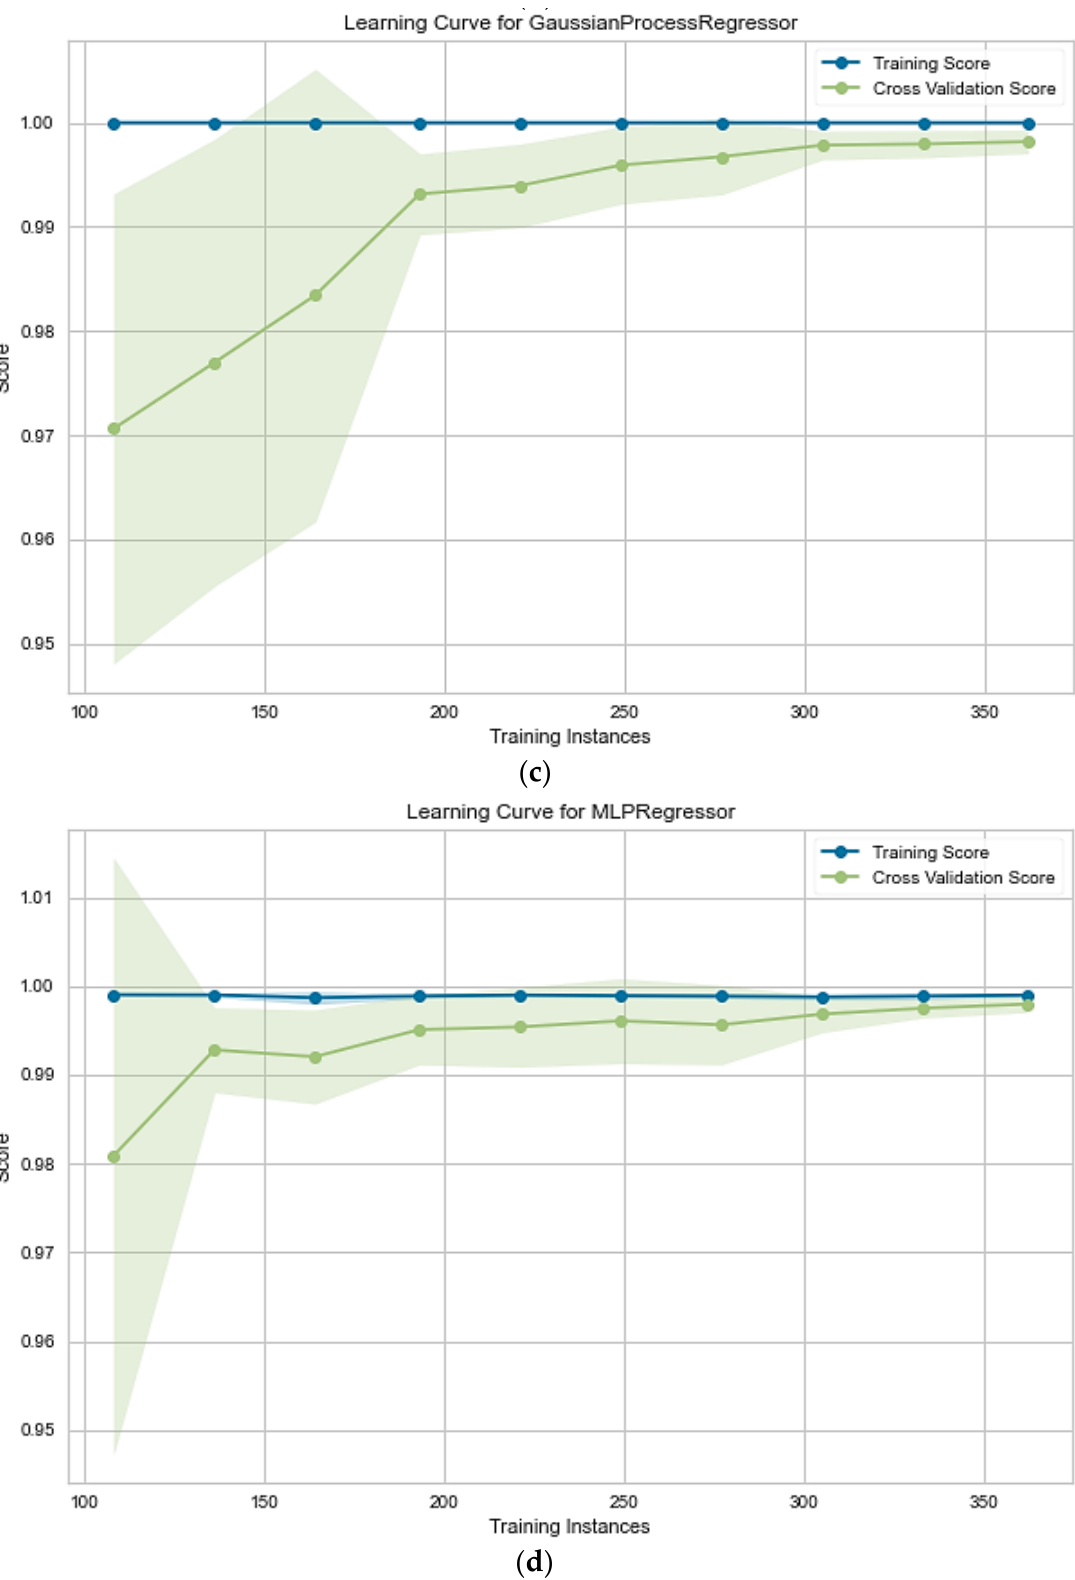
Figure 9. Different machine learning models’ learning curve for ( a ) linear regression; ( b ) support vector regressor; ( c ) Gaussian process; and ( d ) multilayer.